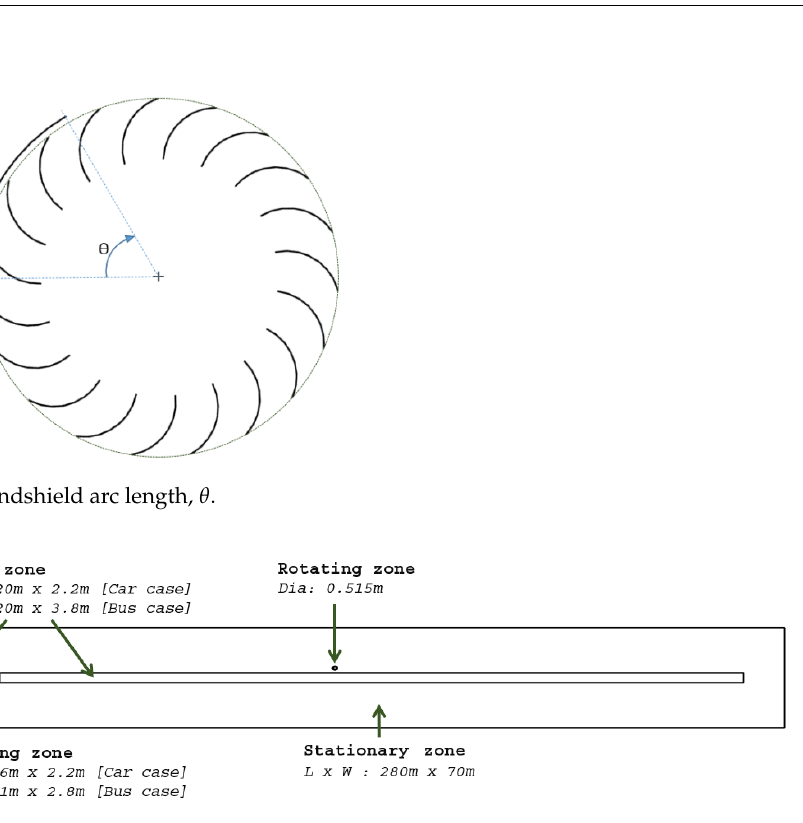
Figure 5. Dimension of cell zones.